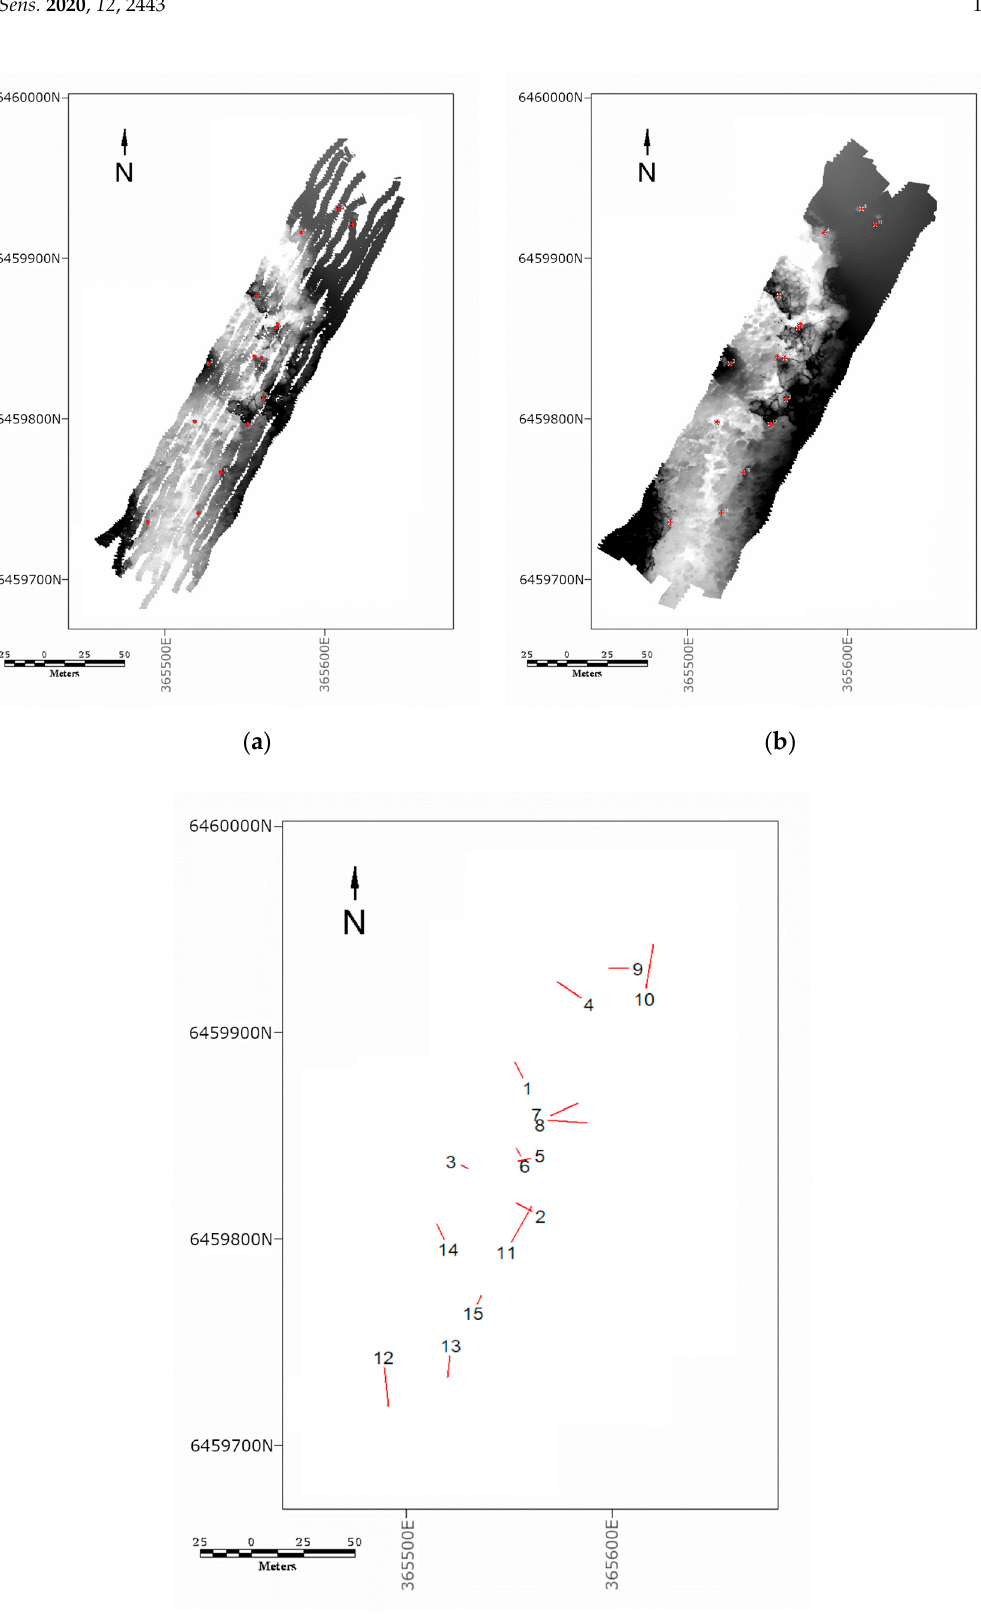
Figure 6. 15 matching control points are manually selected. ( a ) LiDAR and ( b ) MBES. ( c ) Displacement between multibeam and LiDAR control points exaggerated by a factor of 100. Coordinates in SUTM50.